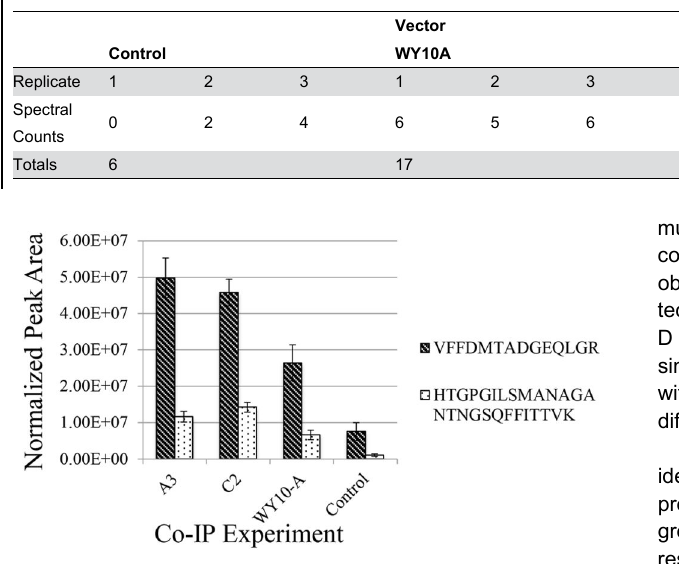
Figure 3. Normalized peak areas from two cyclophilin A peptides show enrichment in co-immunoprecipitation